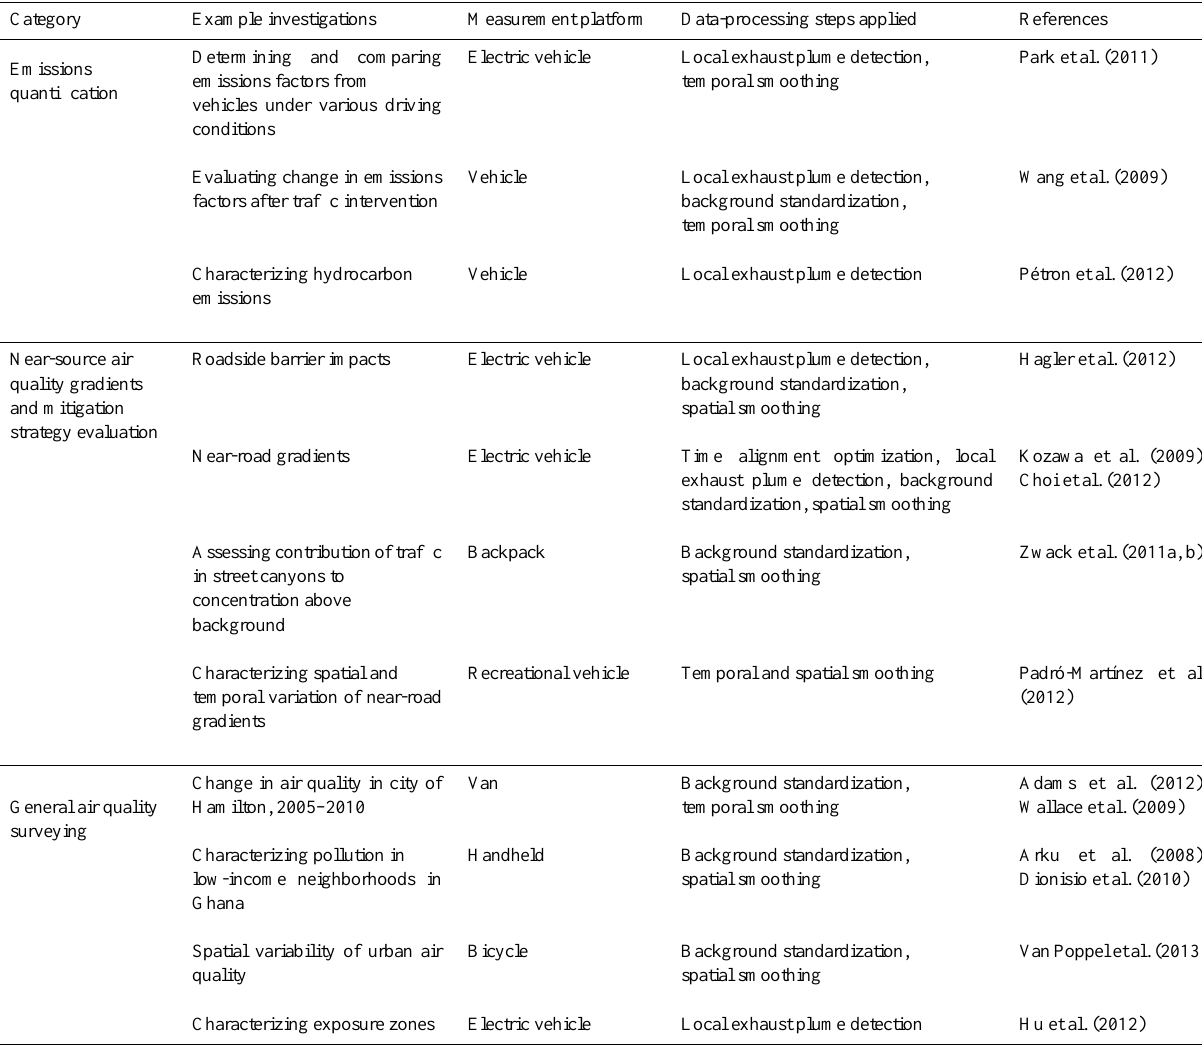
Table 1. Mobile monitoring example